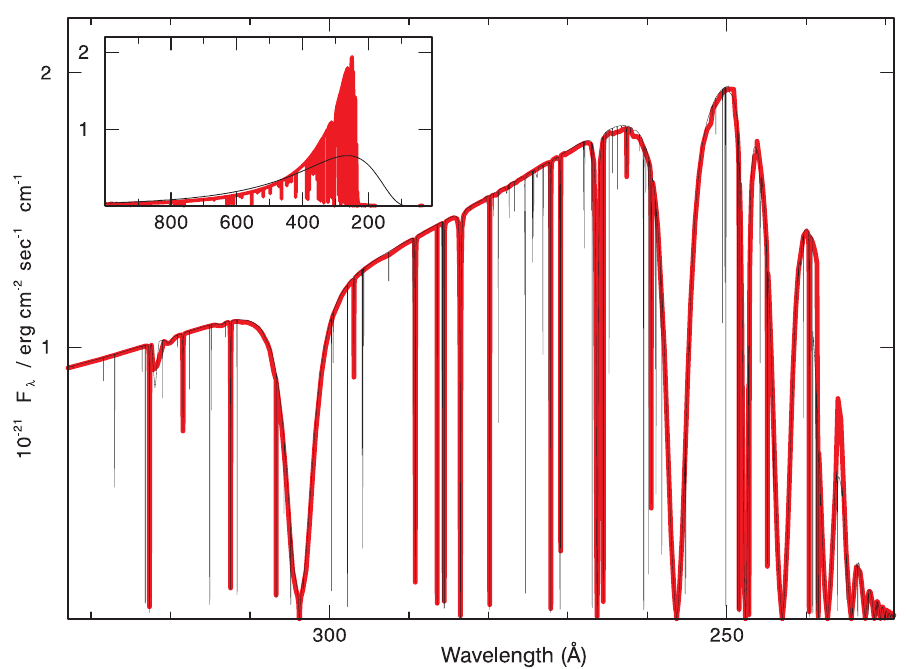
Fig. 6. TMAP (thin line) (cid:13)ux ( T eff = 110 000 K, log g = 7 : 5) compared to a respective TMAW (cid:13)ux (thick, red curve in the online version). The insert shows the strong devi- ation of the blackbody (cid:13)ux (with respective temperature) from the model-atmosphere